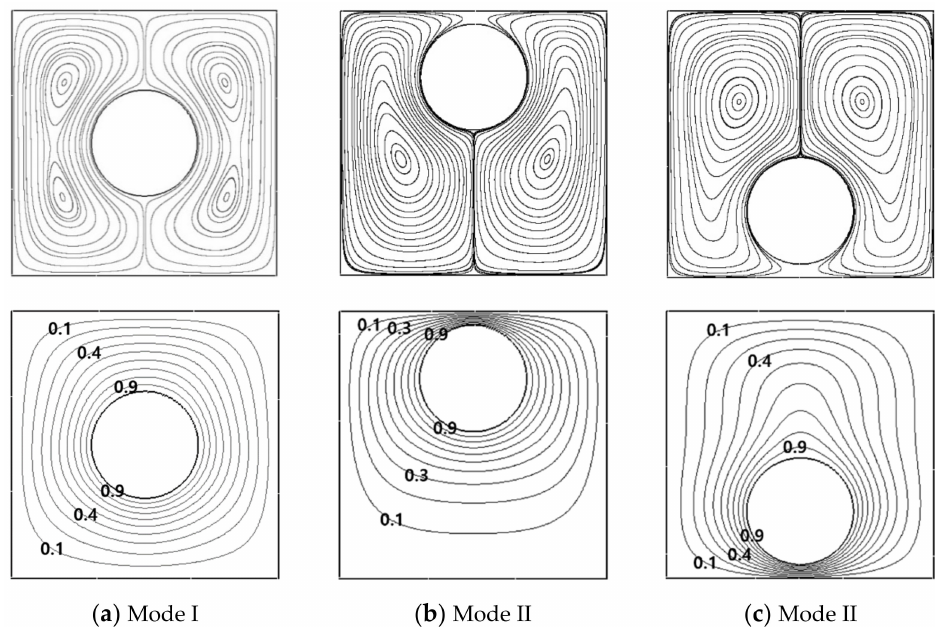
Figure 10. Streamlines (upper row) and isotherms (lower row) at ( a ) ( r = 0, θ = 0 ◦ ), ( b ) ( r = 0.25 L , θ = 90 ◦ ) and ( c ) ( r = 0.25 L , θ = − 90 ◦ ) for Ra = 10 4 . As the cylinder is positioned downward from the enclosure at r = 0 along the vertical center line at θ = − 90 ◦ , two internal vortices merges at r = 0.1 L . Namely, Mode I changes into Mode II, which is earlier than r = 0.15 L at Ra = 10 3 . In Mode II, as r increases